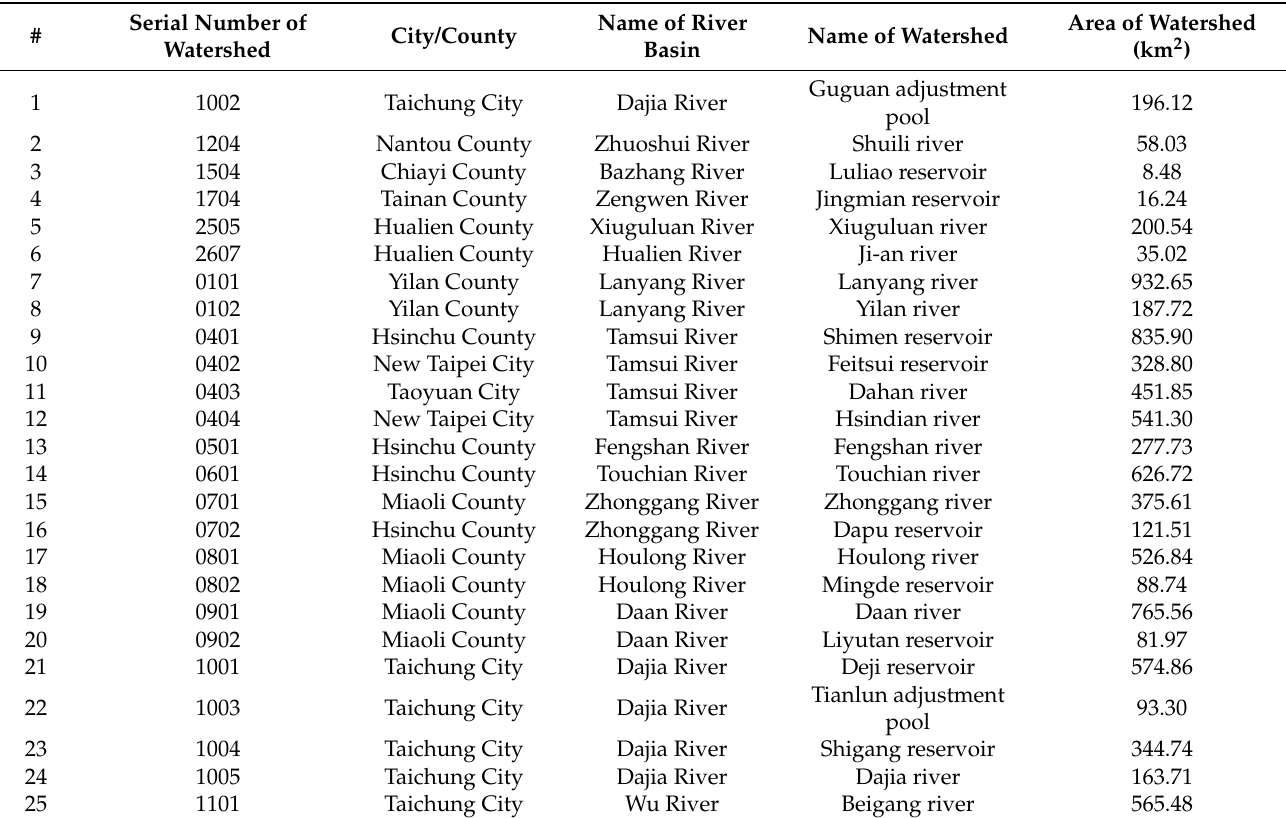
Table A1. List of selected